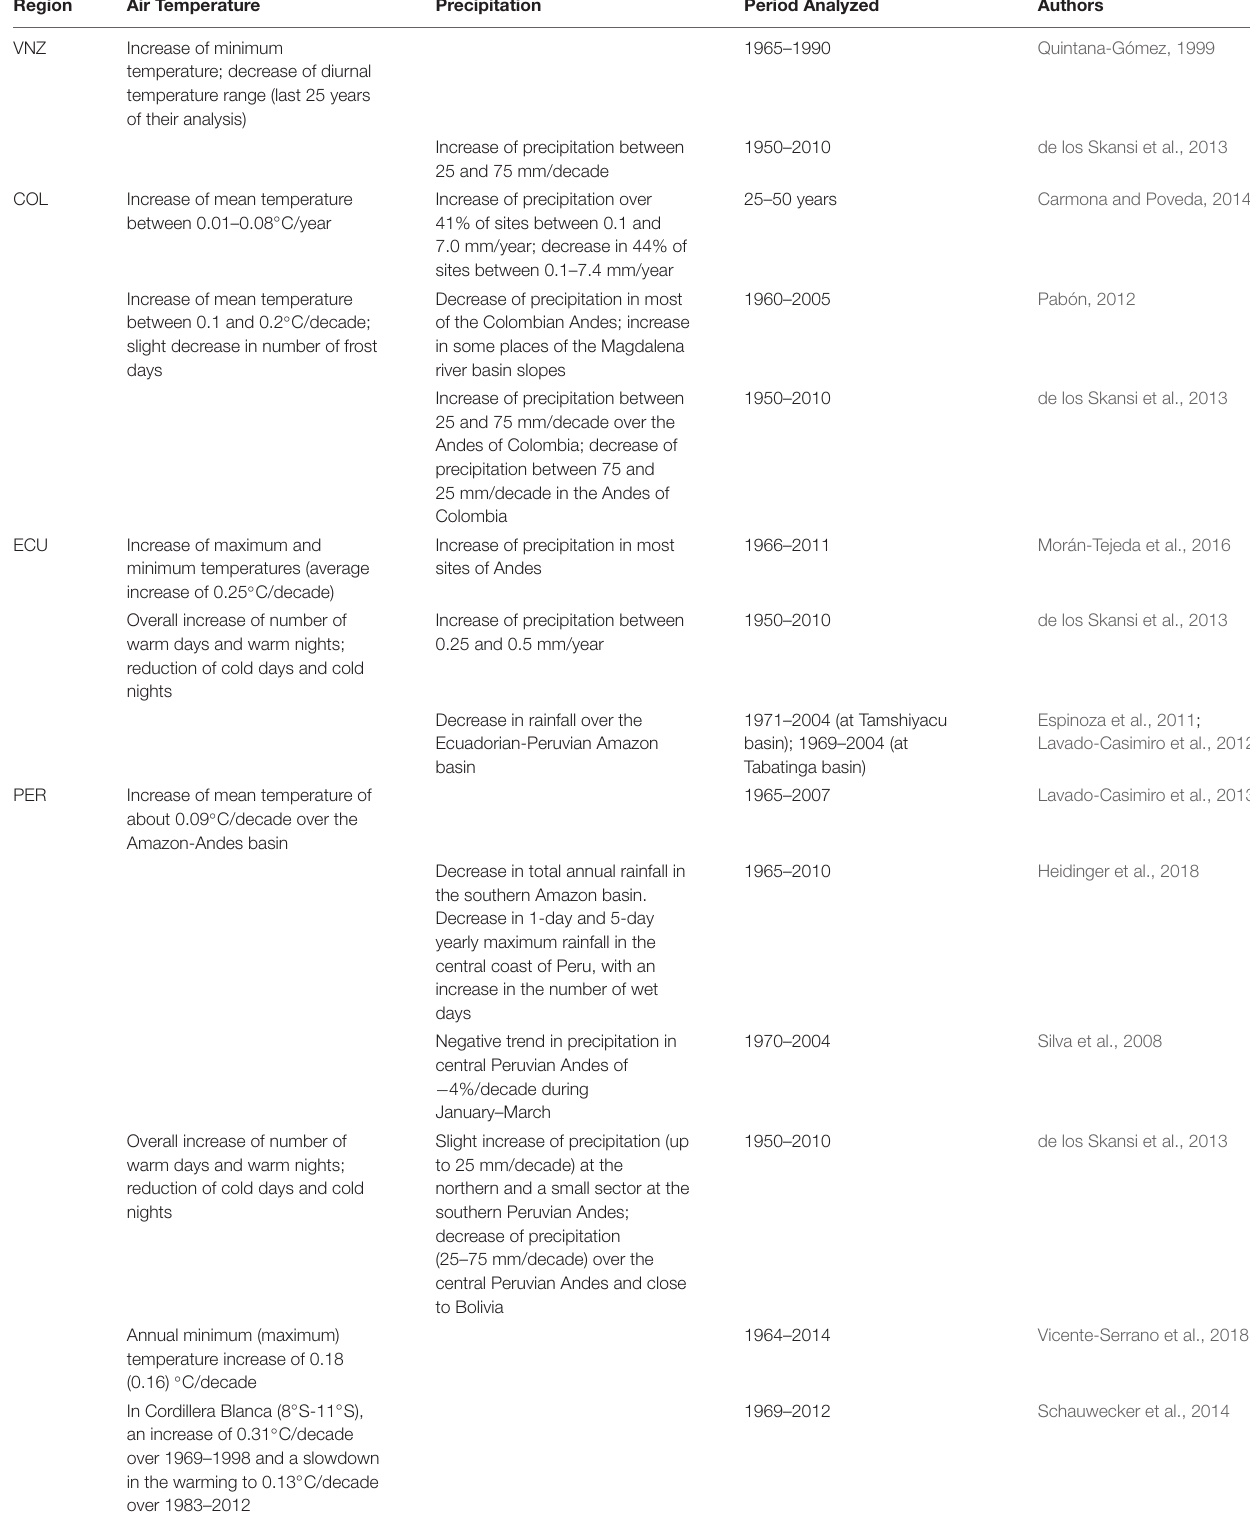
TABLE 1 | Trends detected in air temperature and precipitation in the